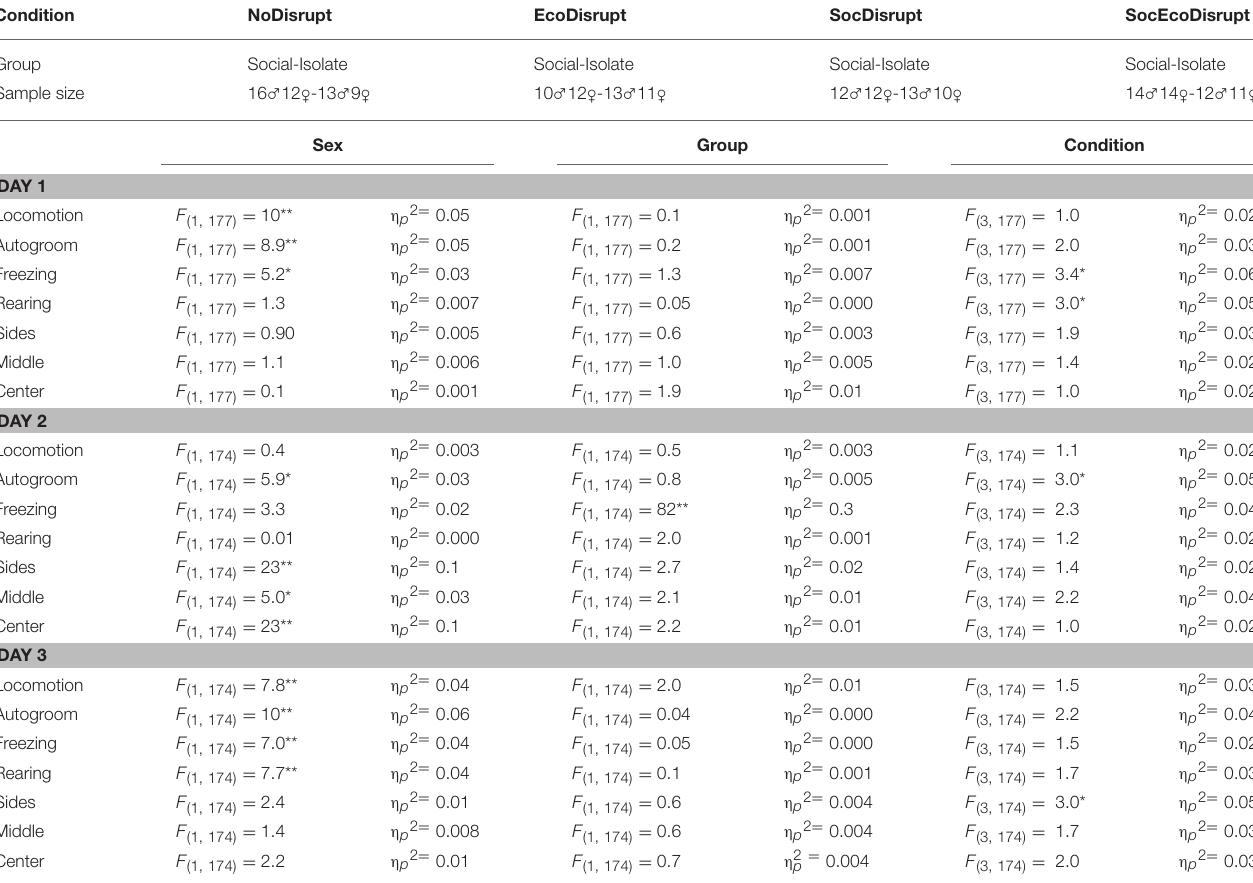
TABLE 1 | ANOVA results for the main effects.